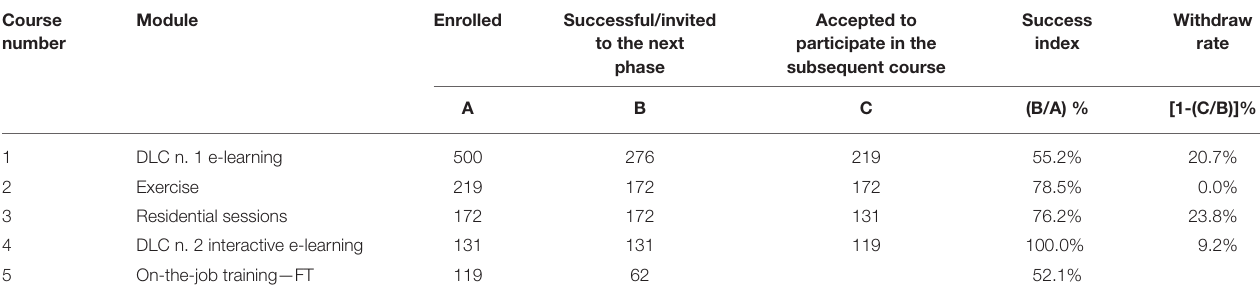
TABLE 1 | Participation pattern described by enrolled, successful, accepted trainees at different phases. Course